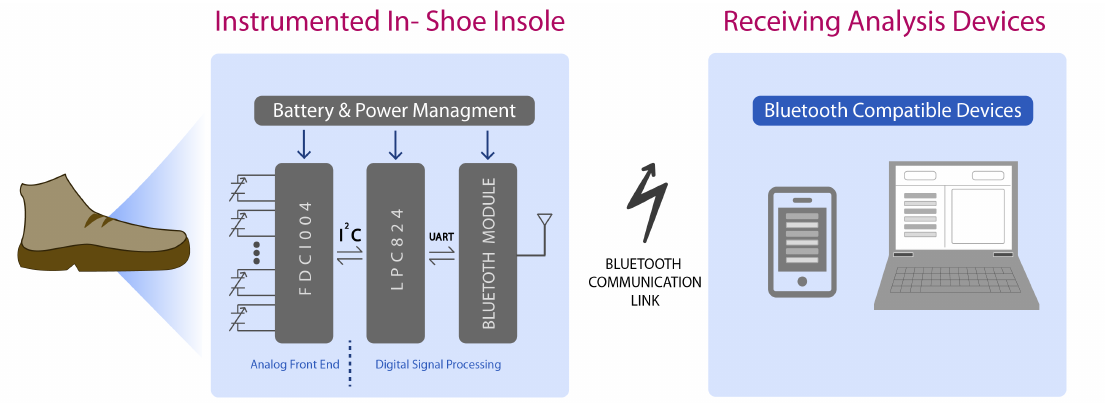
Figure 3. Scheme of system operation.